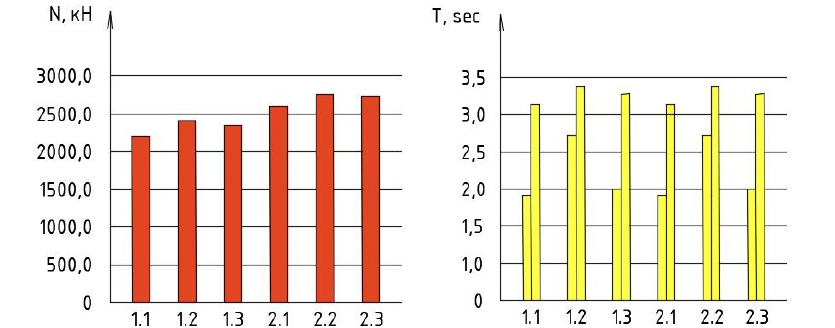
Fig. 2. Comparison of seismic impacts on columns (left) and principal vibration periods